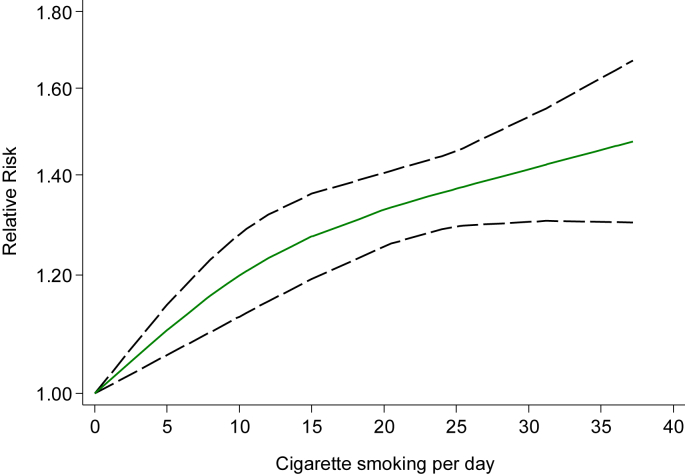
Linear dose-response relationship between cigarette smokes per day and relative risk of diabetes among total subjects (P for non-linearity = 0.08). Data were modeled with random-effects restricted cubic spline models with three knots placed at 10th, 50th, and 90th percentiles of cigarette smokes per day. Lines with long dashes represent the pointwise 95% confidence intervals for the fitted linear trend (solid line). Line with short dashes represents the linear trend.